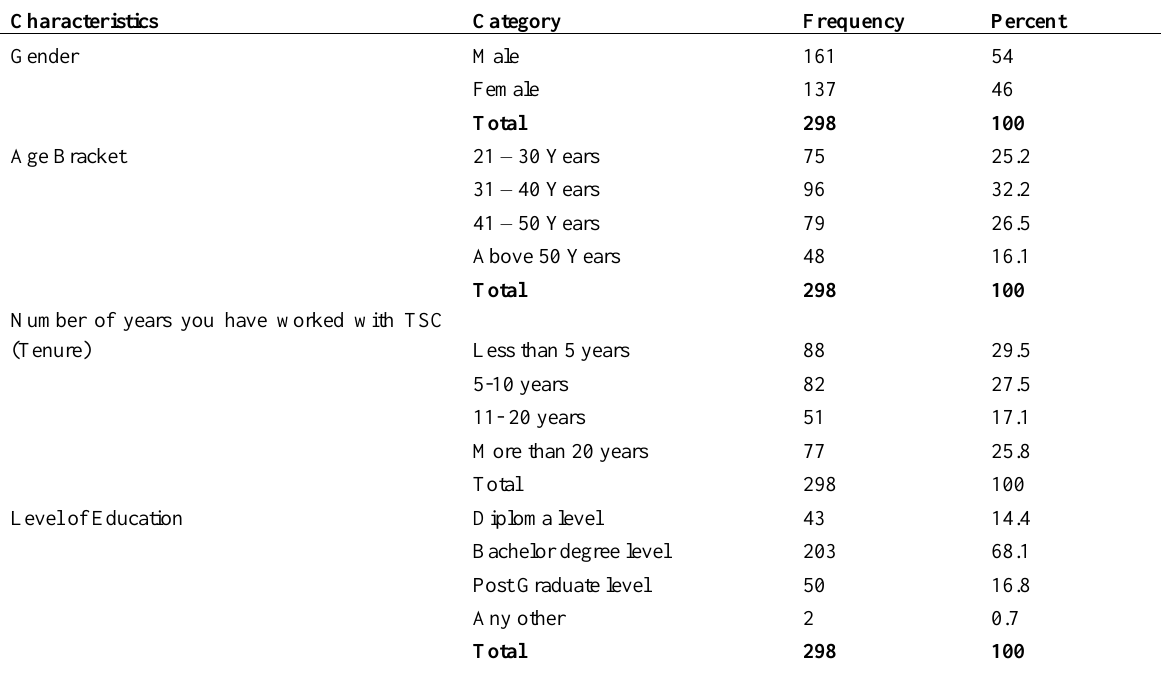
Table 2: Demographic Characteristics of the